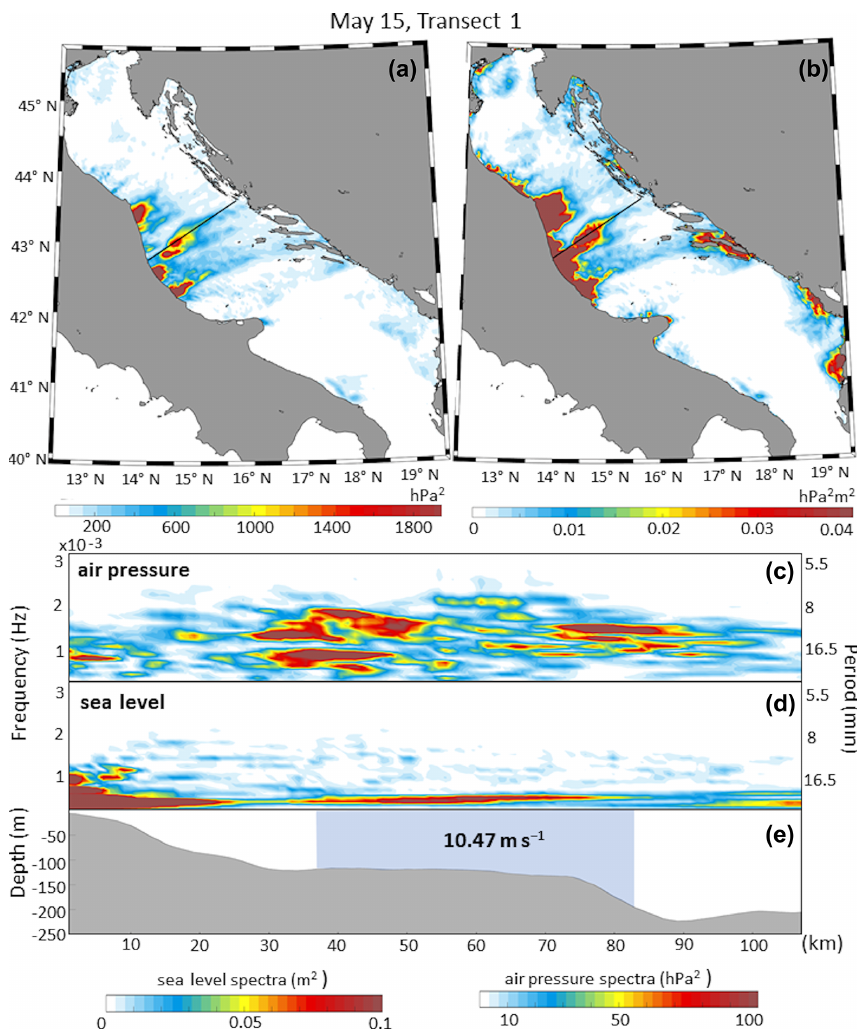
Figure 9. As in Fig. 7, but for the meteotsunamigenic disturbance of 15 May 2020 along Transect